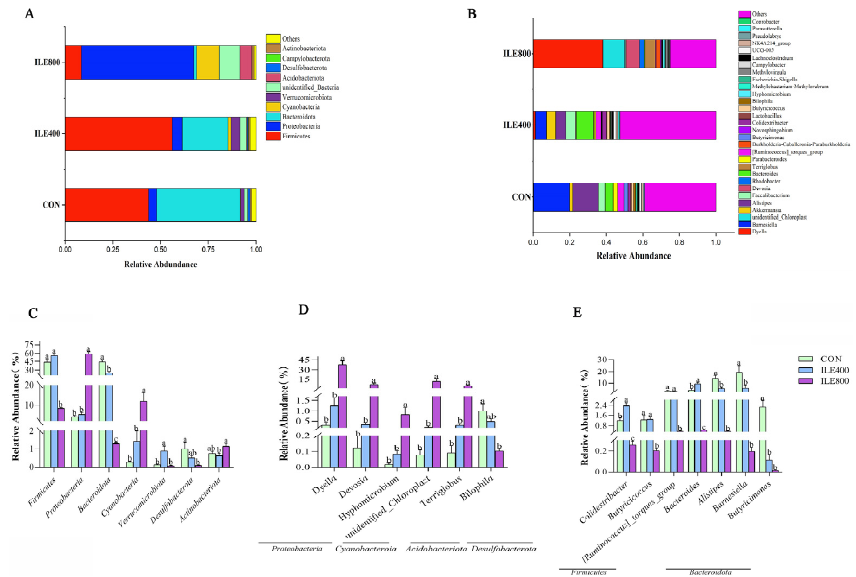
Figure 4. The effect of dietary supplementation with various levels of isoleucine (Ile) on the compo- sition of cecal microbiota. ( A ) Phylum level; ( B ) Genus level; ( C ) The differential microbiota at the phylum level; ( D , E ) The differential microbiota at the genus level. CON, broiler chickens were fed the basal diet; ILE400, basal diet supplemented with 400 mg/kg Ile; ILE800, basal diet supplemented with 800 mg/kg Ile. The values are presented as the mean and standard error of mean (SEM), and statistically significant differences are those with a,b,c p < 0.05.